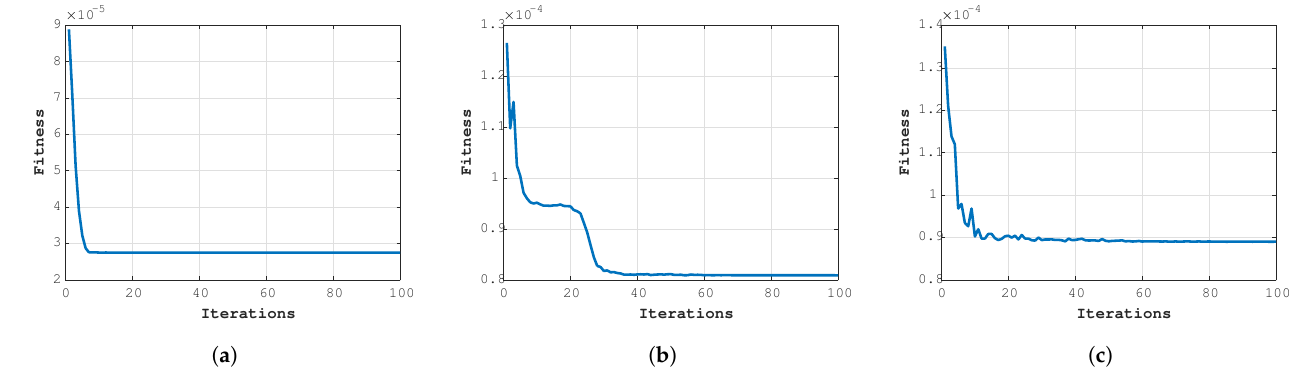
Figure 5. Performance graphs for ( a ) test 1, ( b ) test 2, ( c ), and test